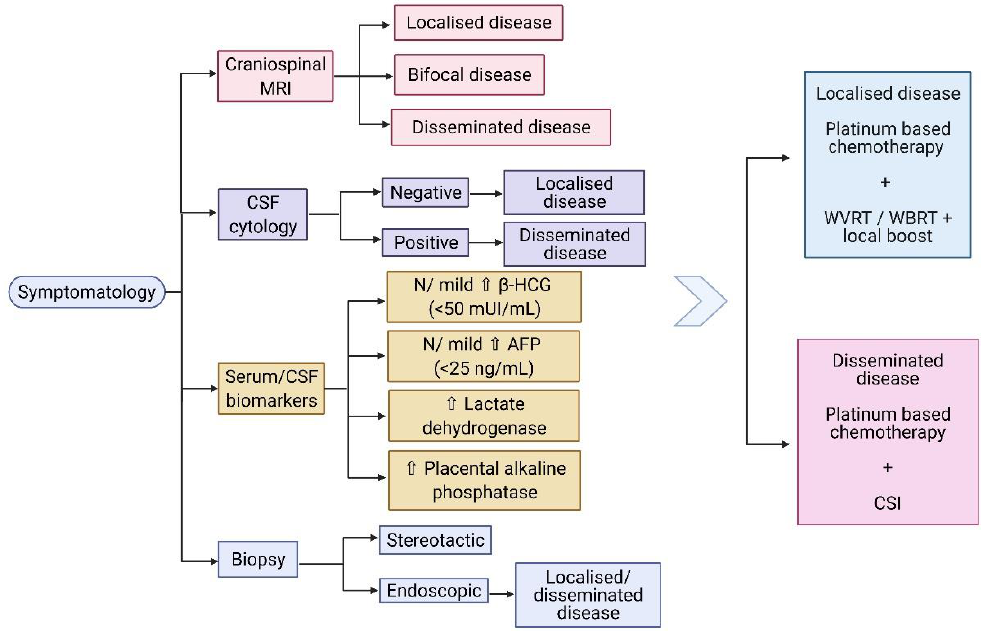
Figure 1. (Created with BioRender.com) Diagnostic algorithm of CNS germinomas. Abbreviations: MRI: magnetic resonance imaging; CSF: cerebrospinal fluid; β-HCG: beta- human chorionic gonadotropin; AFP: alpha fetoprotein; N: normal; WVRT: whole ventricular radiotherapy; WBRT: whole brain radiotherapy; CSI: craniospinal irradiation.